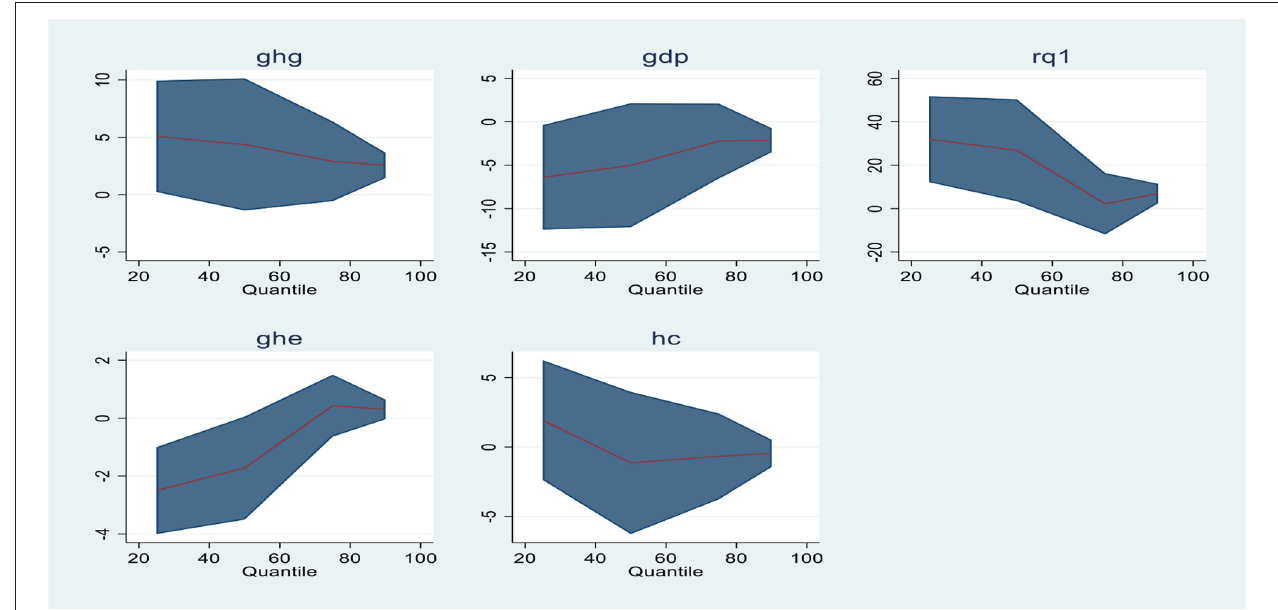
FIGURE 2 | Graphical representation of quantiles for Model